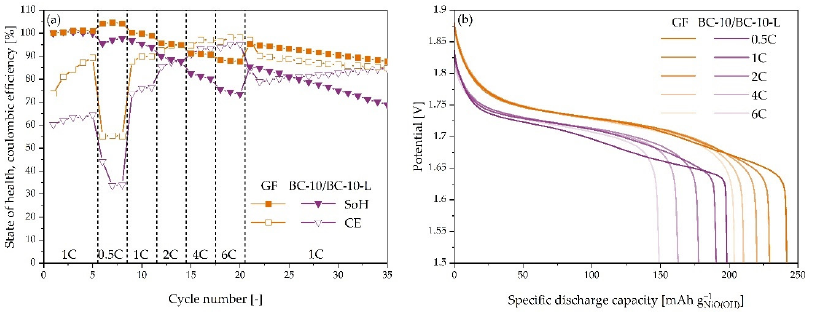
Figure 8. ( a ) State of health and coulombic efficiency with the respective ( b ) discharge voltage profile during C-rate testing of Ni-Zn batteries using a glass-fiber (GF) or a bacterial cellulose (BC) BC-10/BC-10-L separator.